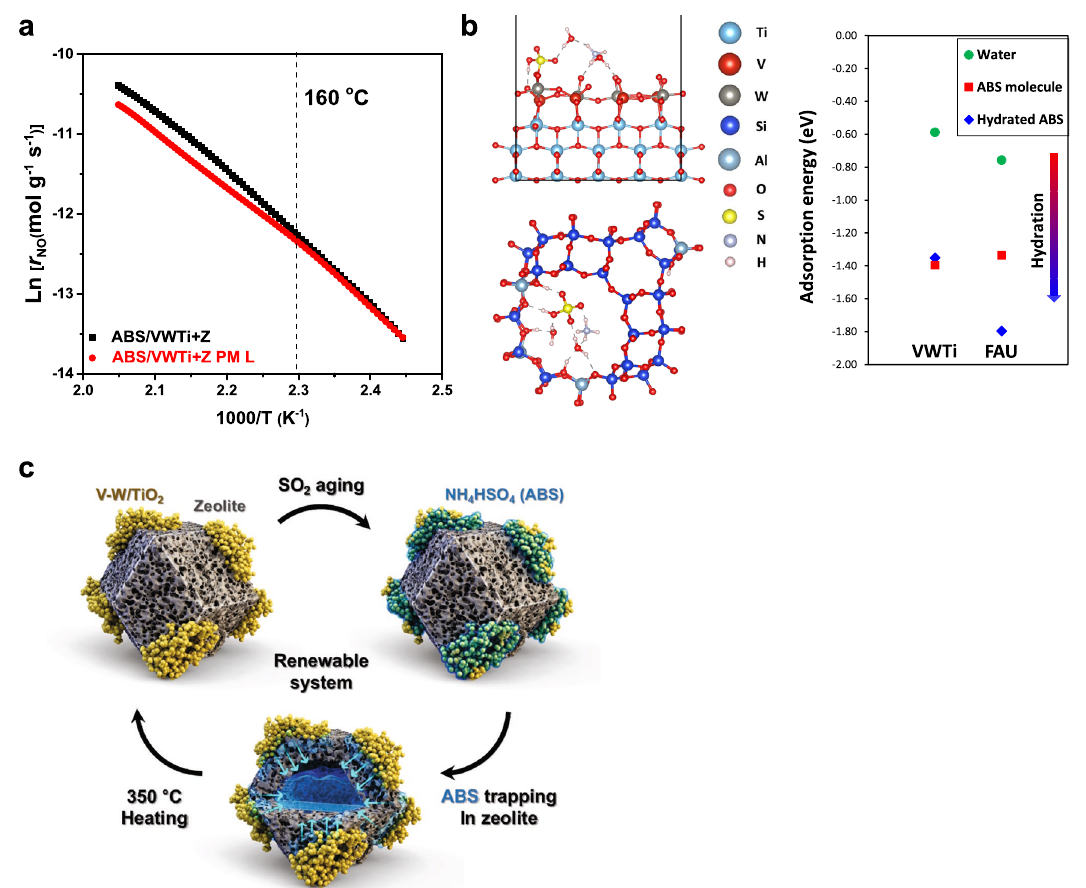
Fig. 3 ABS trapping model by liquid phase migration. a Arrhenius plots of ABS/VWTi + Z (black dot) and ABS/VWTi + Z PM L (red dot) during transient NH 3 -SCR reaction (temperature from 100 °C to 220 °C with ramp rate 1 °C/min, Reaction gas contains 500 ppm NO, 500 ppm NH 3 , 10% O 2 , 5% CO 2 , and 10% H 2 O balanced with N 2 ; NO x conversion pro fi les in Supplementary Fig. 11a). b DFT calculation results regarding the stability of hydrated ABS by two H 2 O molecules on the VWTi and H – Y zeolite. c Schematic illustration of an operating principle of the ABS trapping in the VWTi + Z